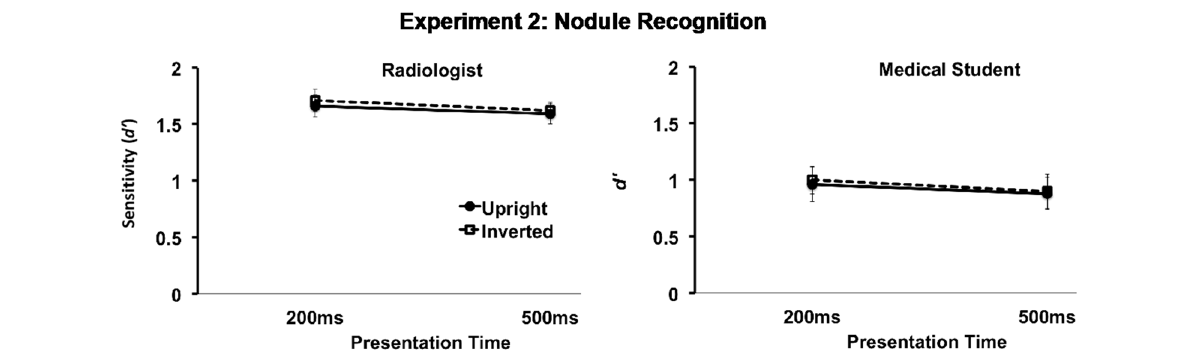
Fig. 3 Experiment 2 (Nodule Recognition) results. Performance, as measured by sensitivity d ′ , on the nodule recognition task for radiologists (left) and medical students (right) on upright and inverted X-rays presented for 200 ms and 500